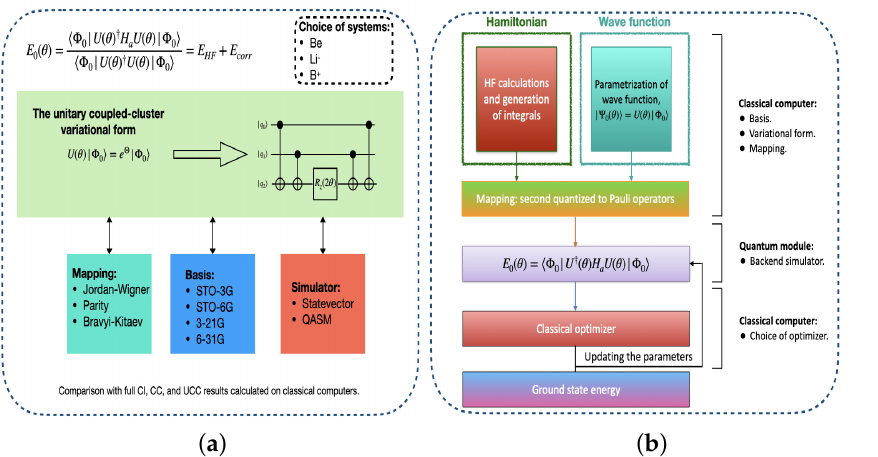
Figure 1. ( a ) A schematic demonstrating evaluation procedure of Equation (1) using the variational quantum eigensolver algorithm. It includes different combinations of mapping (in green), basis sets (in blue), and backend simulator (in red) to capture the correlation effects. A sample template unitary coupled-cluster circuit is provided for the case of three qubits ( q 0 , q 1 , and q 2 ), built out of CNOT and R z ( 2 θ ) gates. The figure lists the atomic systems chosen for the investigation, and it also mentions about the comparison of our variational quantum eigensolver results with those obtained on a classical computer by employing various many-body methods. ( b ) An overview of the variational quantum eigensolver algorithm applied to electronic structure problem, which requires generating the one-body and two-body integrals of atomic Hamiltonian, expressing the wave function in parametric form and adopting quantum modules for computation. The guess parameters are then updated each time in an iterative procedure on a classical optimizer until a global minimum is